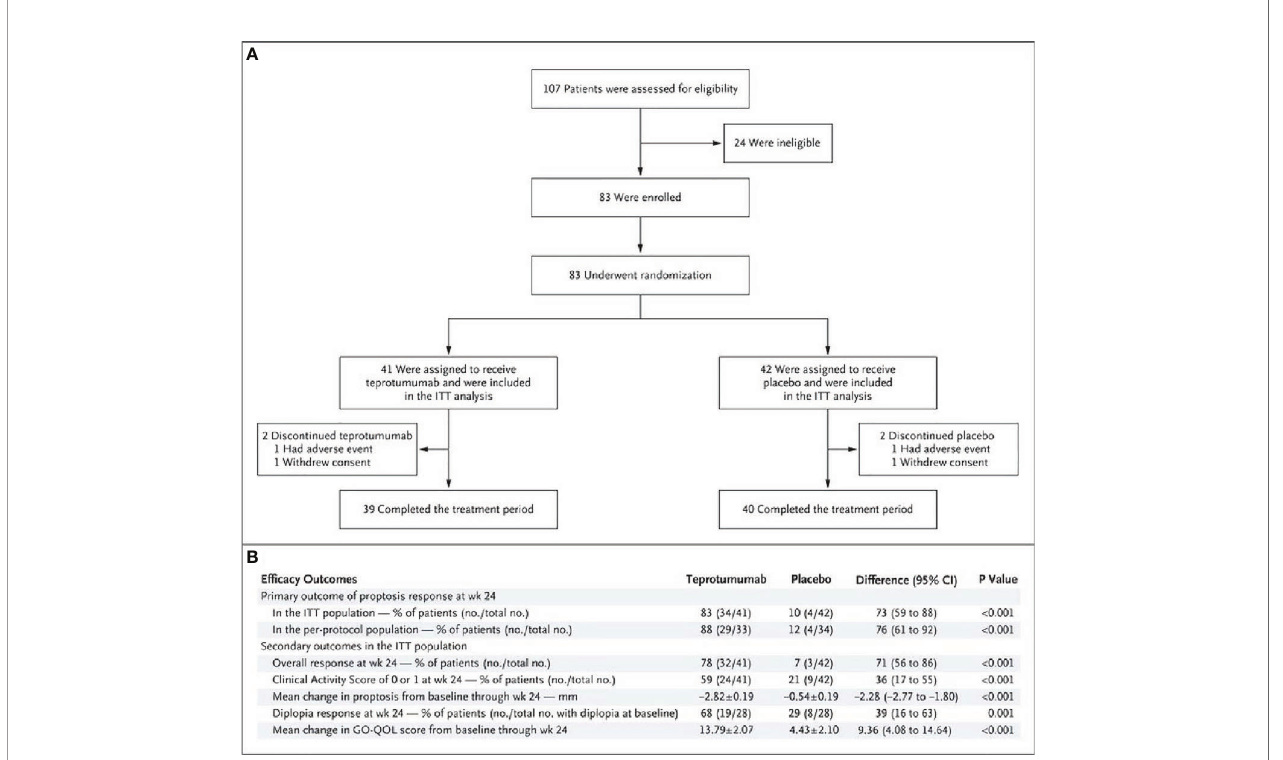
FIGURE 5 | (A) Trial pro fi le describing enrollment, randomization, and follow-up. Random assignment to subgroups receiving intravenous infusions of either teprotumumab (10 mg/Kg B.W. for test infusion and 20 mg/Kg for subsequent infusions) or placebo. Infusions administered every 3 weeks for 21 weeks eight infusions in total. (B) Ef fi cacy Endpoints describing the phase 3 trial of teprotumumab in patients with moderate to severe active TAO. CMH weighting was used to estimate the common risk difference and the 95% Con fi dence Interval (95% CI) of the common risk difference for the primary and secondary endpoints of overall responder, percent with CAS 0 or 1, and diplopia responder; least squares mean difference was calculated for secondary endpoints of change in proptosis from baseline and change in Graves ’ Orbitopathy quality of life (GO-QOL) questionnaire from baseline using the Mixed-Model Repeated-Measures (MMRM) analysis of covariance (ANCOVA). From N. Engl. J. Med, Douglas R.S, Kahaly G.J., Patel A., Sile E.H.Z., Thompson R. et al. Teprotumumab for the treatment of active thyroid eye disease. 382; 341-352. Copyright © (2020) Massachusetts Medical